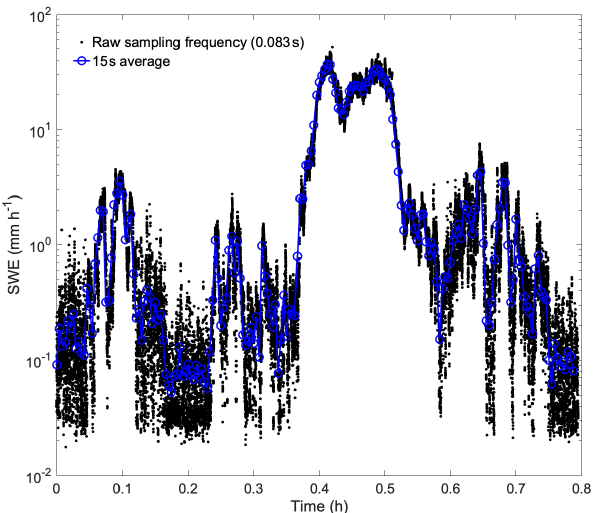
Figure 11. Time series of SWE accumulation measured using the DEID and ETI gauge along with DEID-measured snow density. The data were acquired at Alta-Collins on 16 April 2020. Each DEID data point represents a 5min